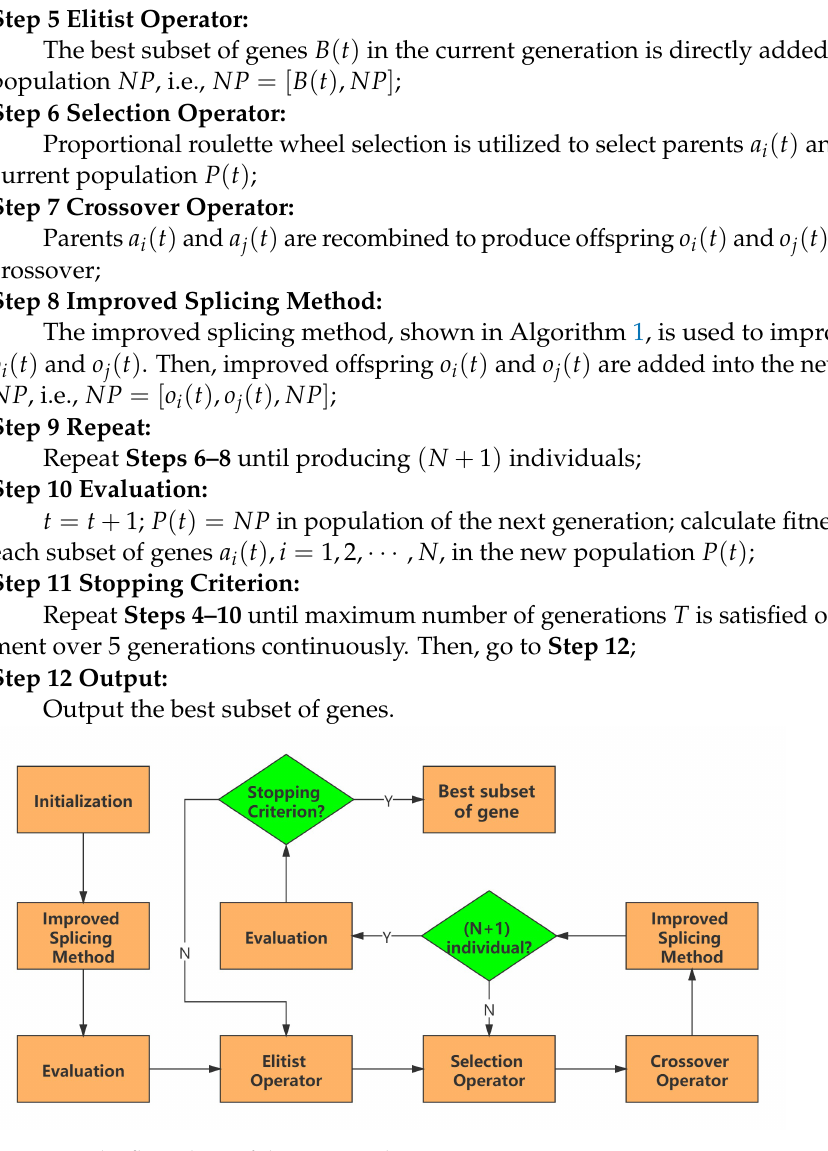
Figure 2. The flow chart of the proposed